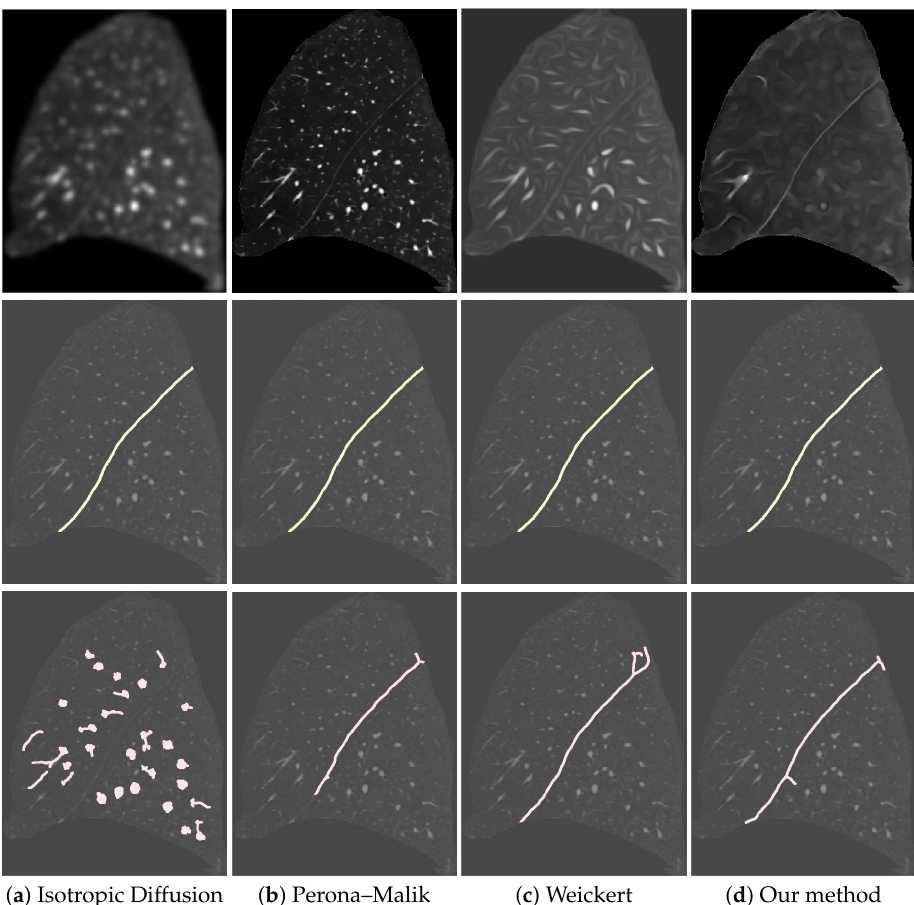
Figure 5. Example of detection results for a curvilinear structure in the lung CT (saggital) image using ( a ) isotropic diffusion, ( b ) anisotropic diffusion proposed by Perona–Malik, ( c ) coherence-enhancing diffusion proposed by Weickert, and ( d ) recursive anisotropic diffusion via our proposed algorithm.